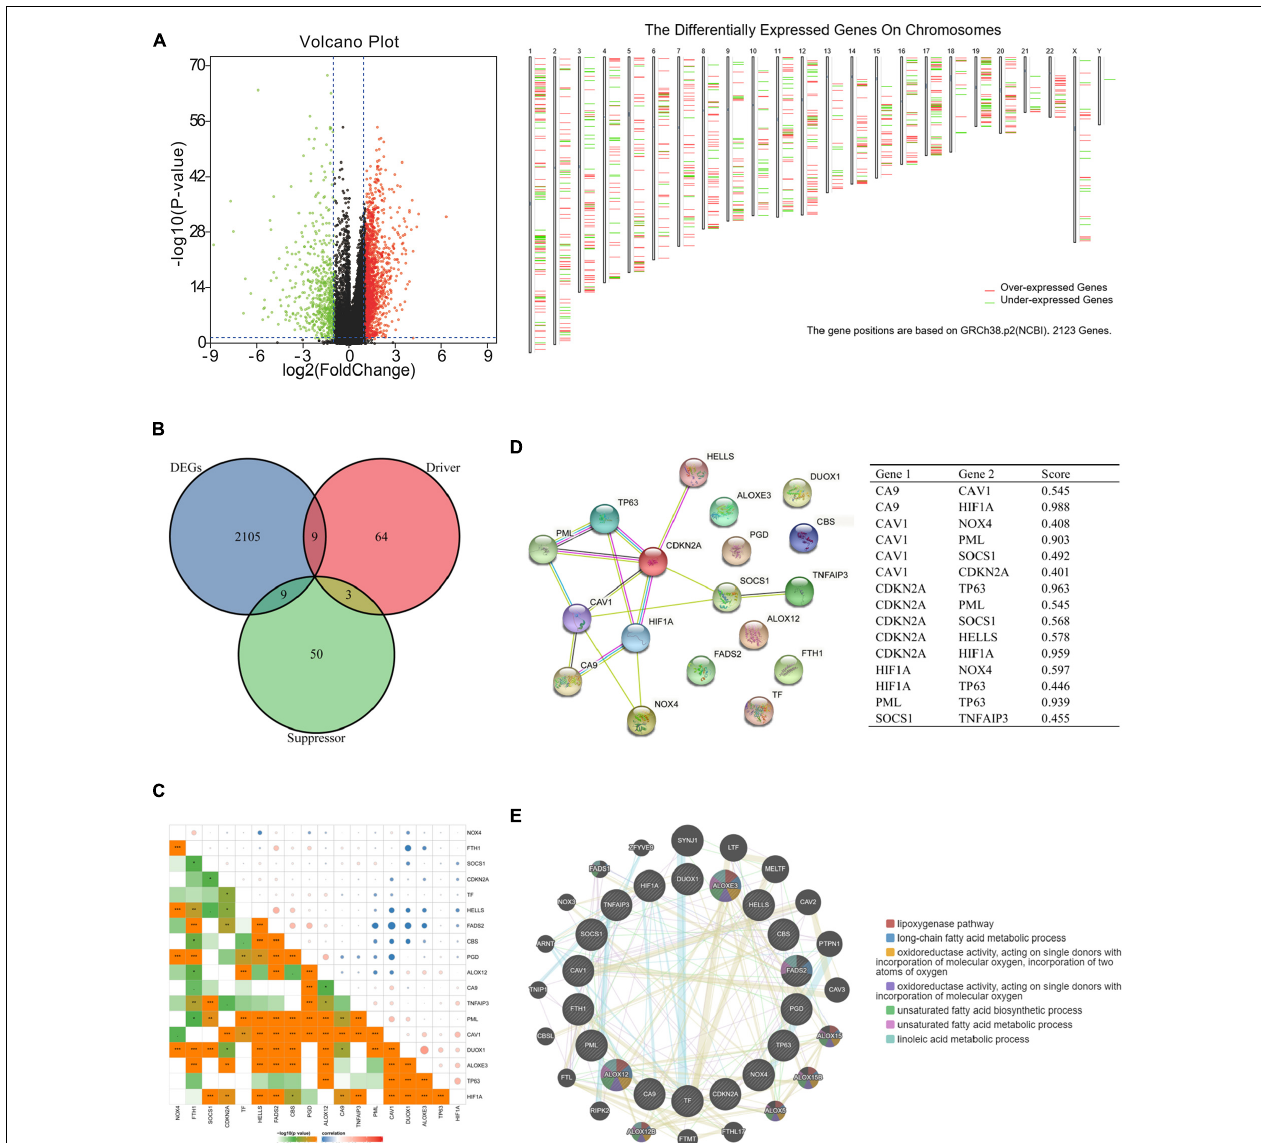
FIGURE 1 | Ferroptosis-related differentially expressed genes (DEGs) and protein–protein interaction (PPI) analysis. (A) Volcano plot and chromosomal localizations of DEGs in head and neck squamous cell carcinoma (HNSCC) (“limma” analysis) (B) Venn diagram of common genes encoding ferroptosis drivers and suppressors that correlated with DEGs (R package analysis). (C) The correlation of expressions between each two genes of the 18 selected ferroptosis-related genes. (D) Annotation of ferroptosis-related differentially expressed proteins and their co-expression scores (STRING analysis). (E) PPI network of ferroptosis-related DEGs (GeneMANIA analysis), ALOXE3 and ALOXE12 were primarily related to the lipoxygenase pathway, while ALOXE3, ALOXE12, FADS2 were primarily related to the long-chain fatty acid metabolic process.